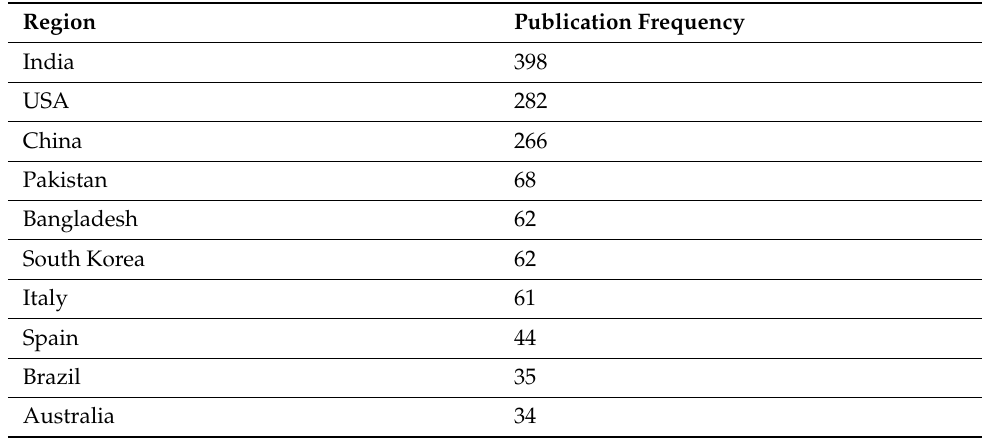
Table 3. Country’s Scientific